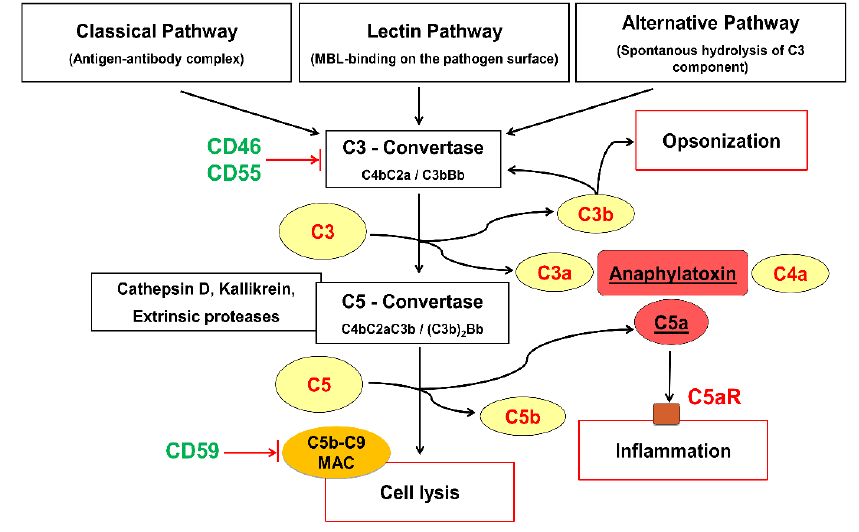
Figure 1. Simplified scheme of the complement activation and regulation processes. C5aR: C5a receptor, MAC: Membrane attack complex, MBL: mannose binding lectin. The image was self-made by Sandeep Silawal.